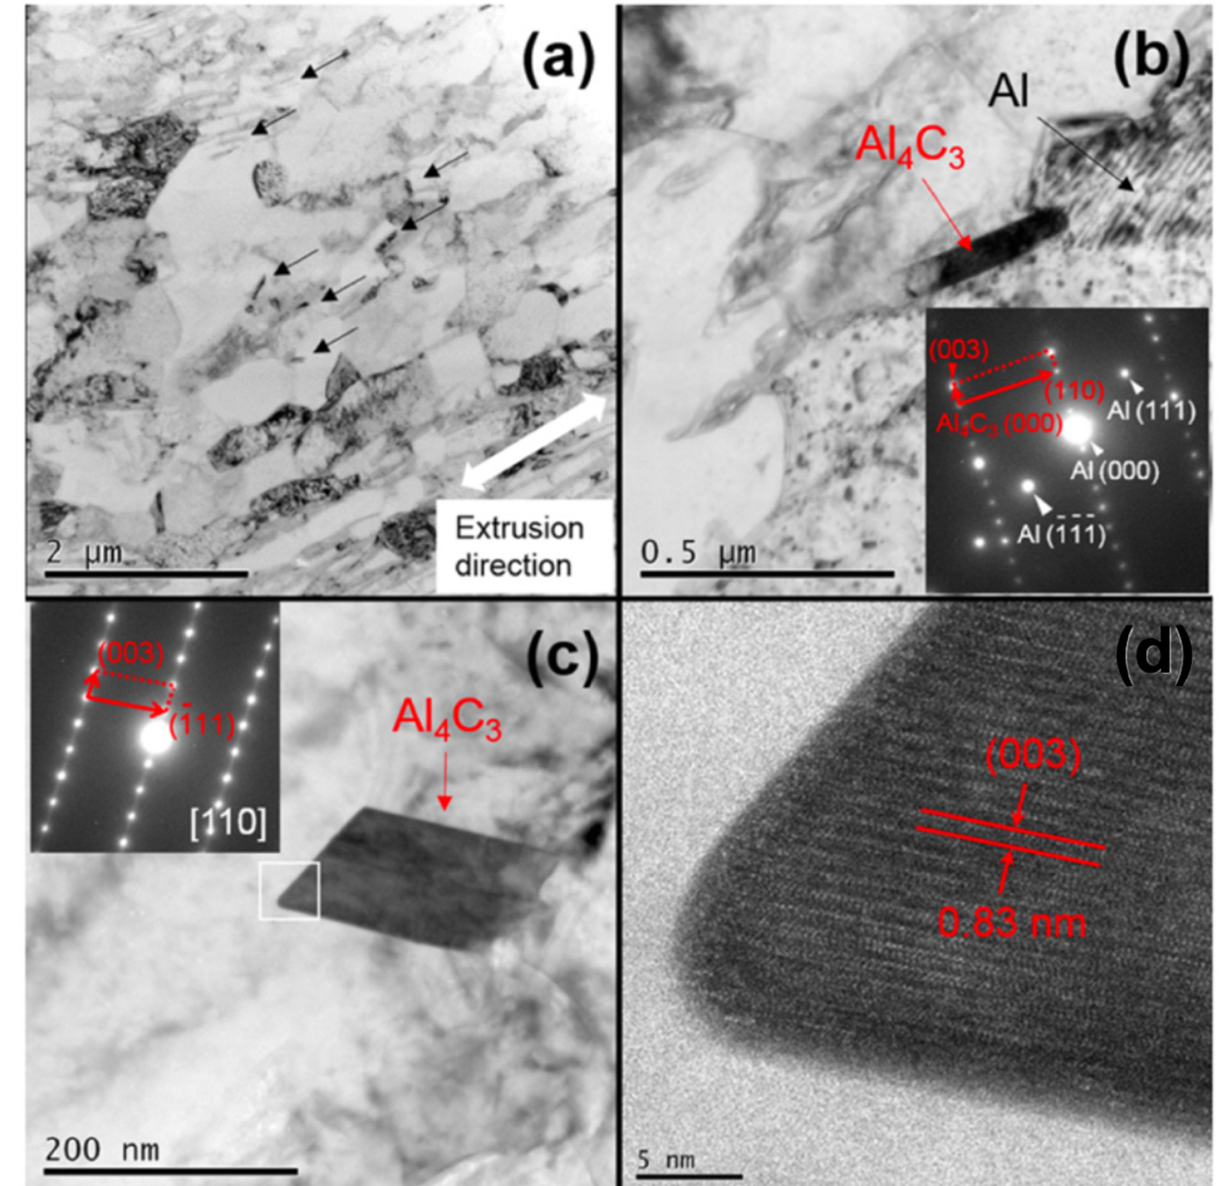
Figure 15. ( a ) TEM image showing the Al 4 C 3 in the matrix; ( b ) and ( c ) TEM images and SAED of an Al 4 C 3 particle, and ( d ) HRTEM image of Al 4 C 3 . Adapted from [94] with permission from John Wiley and Sons,